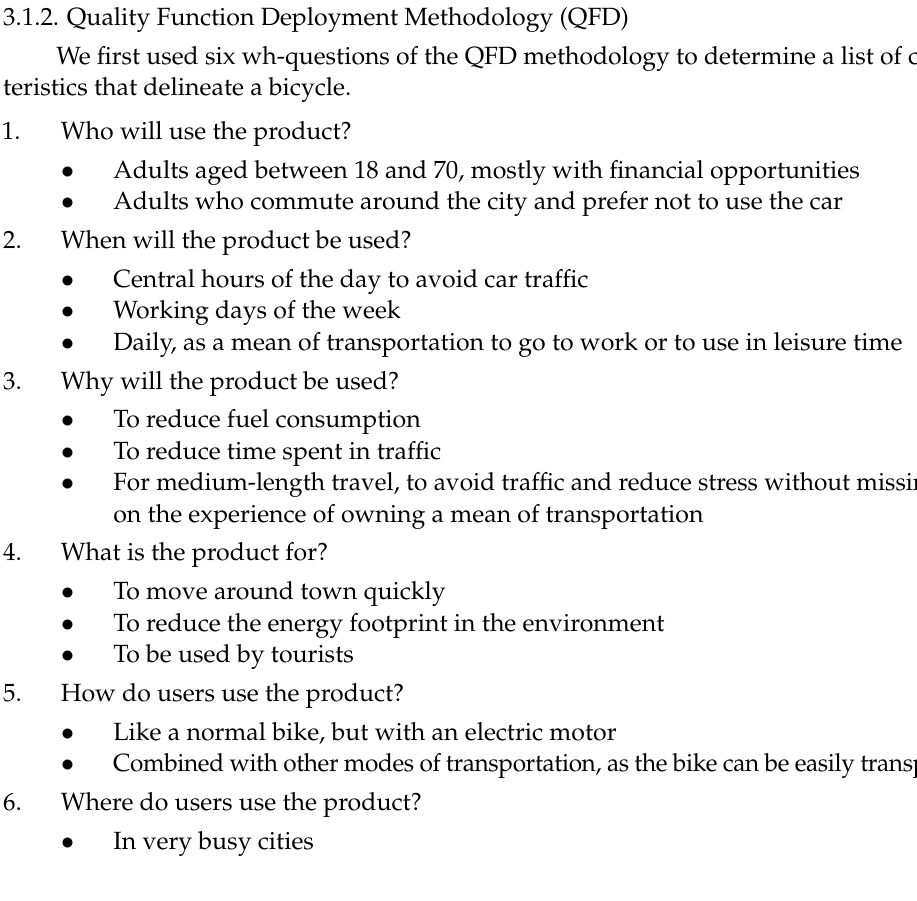
Figure 2. IPB (INTERNAL PRODUCT BIKE) STRUCTURE. Figure 2. IPB (Internal Product Bike)